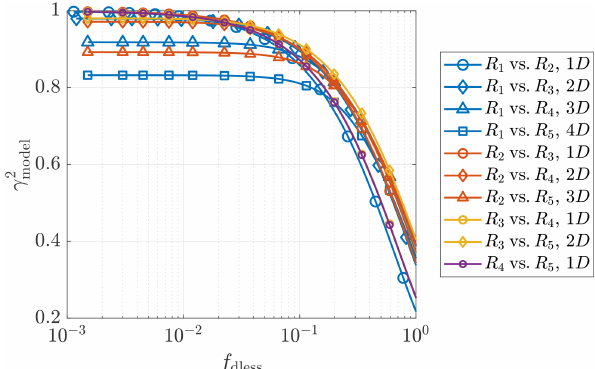
Figure A5. Fitted curves of the estimated coherence between the lidar wind speeds measured at different range gates. The range gates R 1 to R 5 are located at 150, 270, 390, 510, and 630m, respectively. 1 D = 120m. The mean lidar wind speed U l is 11.6ms − 1 . Date and time: 12 June 2019 at 22:30–23:00. Data source: